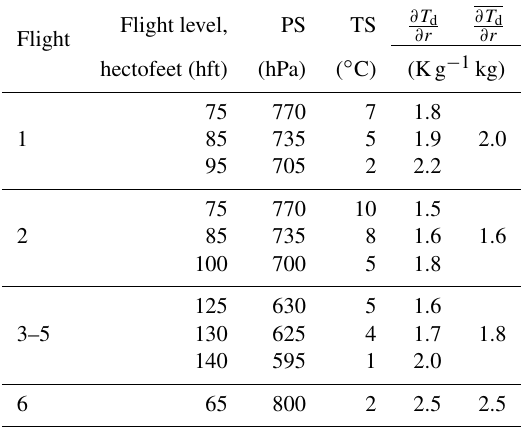
Table 5. Change in saturation dew-point temperature depending on water vapour mixing ratio for different dew-point temperatures (TS) and pressures (PS) during the measurement flights. The last column gives the estimated average value which is used for the temperature correction described in Sect. 2.4. Flight Flight